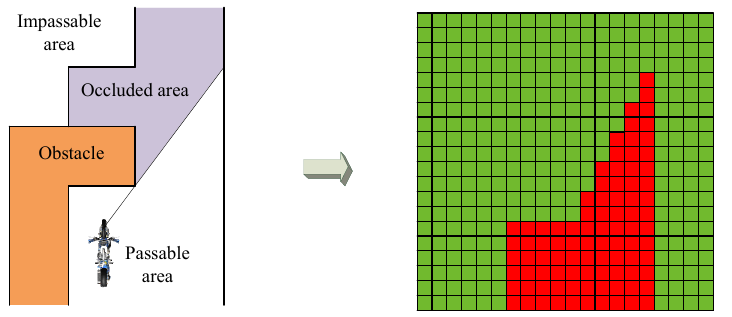
Figure 11. The process of line-of-sight occlusions in state s A .